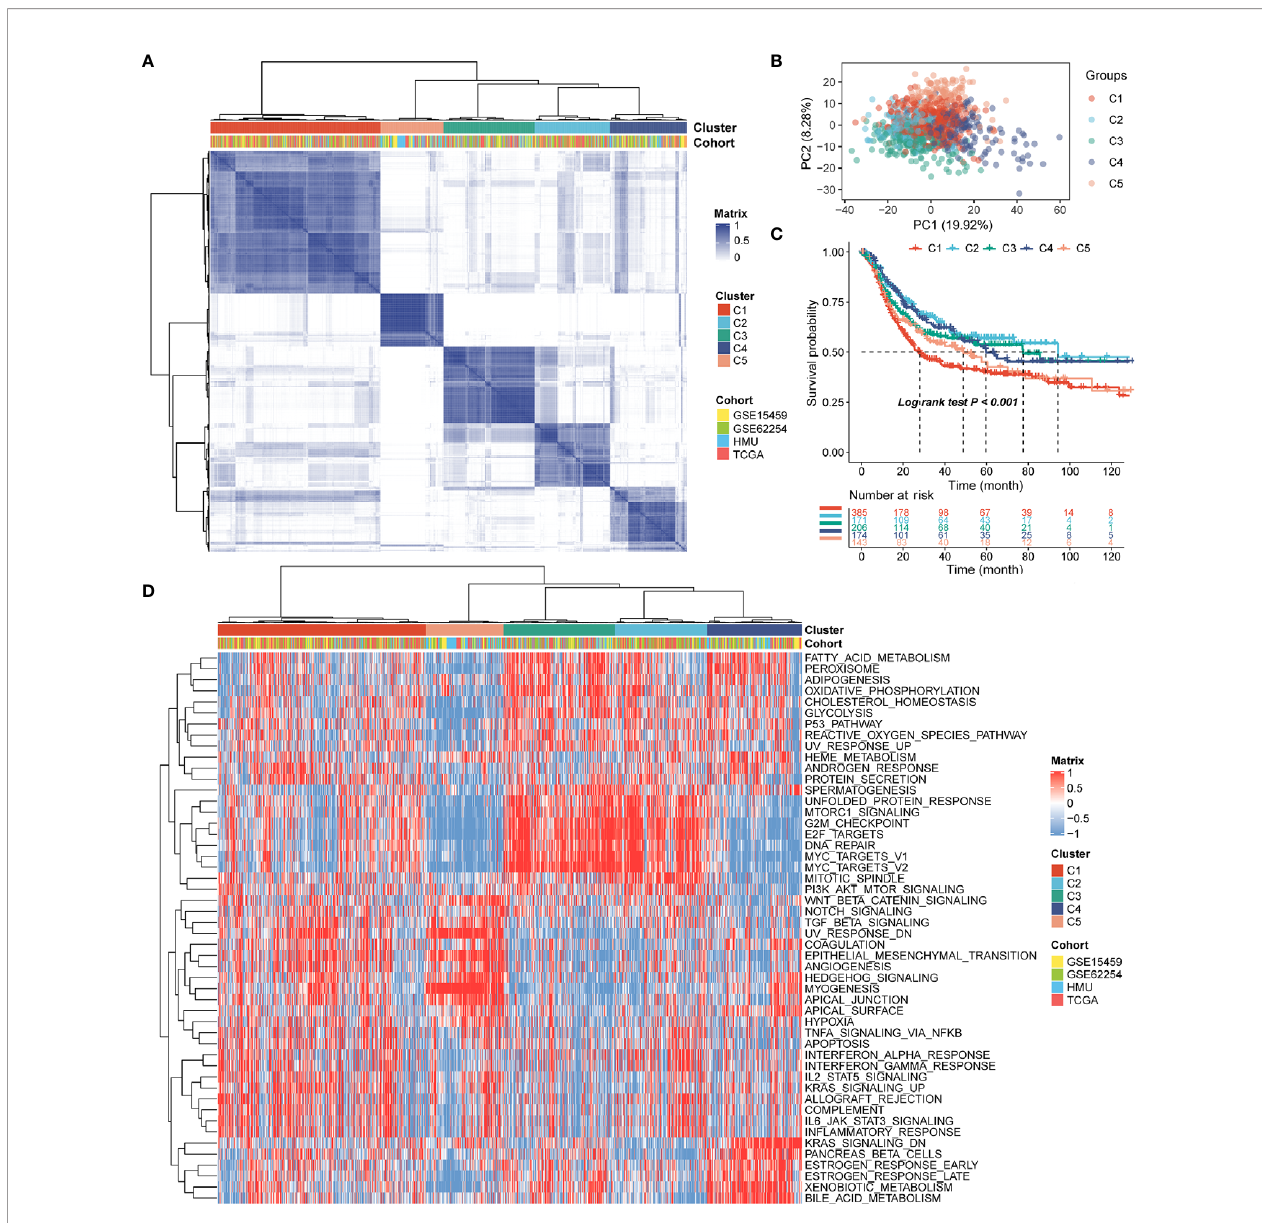
FIGURE 1 | Identi fi cation of the fi ve distinct RNA processing patterns. (A) Heatmap showing consensus clustering analysis for the fi ve de fi ned RNA processing patterns. (B) Scatter plots showing principal component analysis (PCA) of the fi ve distinct RNA processing patterns. (C) Kaplan – Meier survival analysis of OS for patients with the fi ve distinct RNA processing patterns. (D) Heatmap showing GSVA scores of the hallmark gene sets for the fi ve de fi ned RNA processing